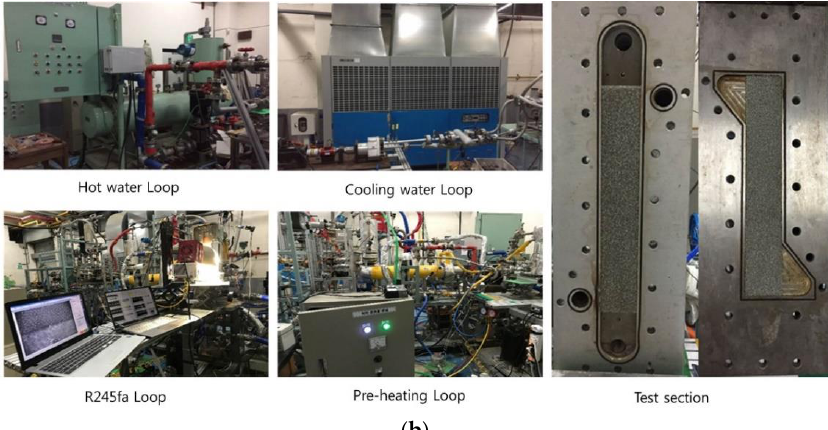
Figure 3. Block diagram of the test loop ( a ) and actual pictures ( b ).